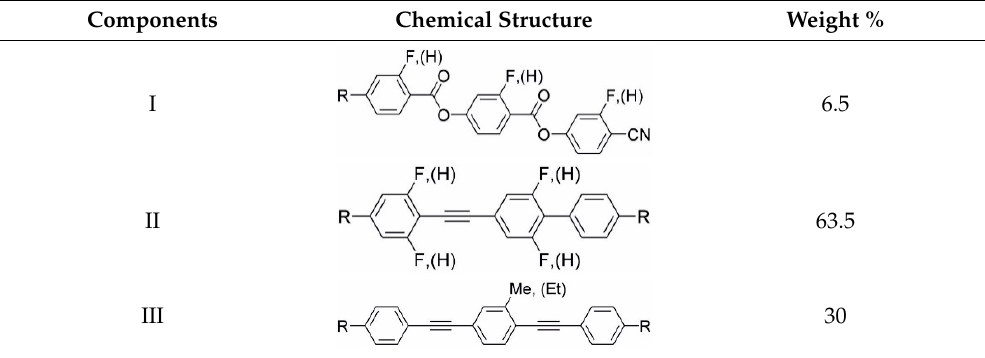
Table 1. General molecular structures of compounds used to form the investigated nematic mixture and their weight %.